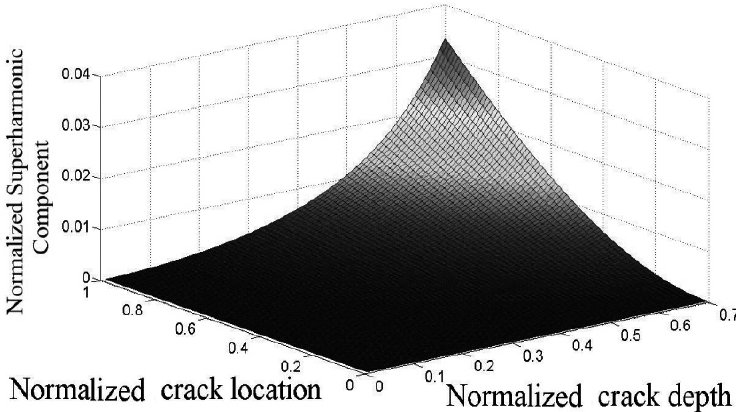
Fig. 8. The ratio of the correction term to the main part of